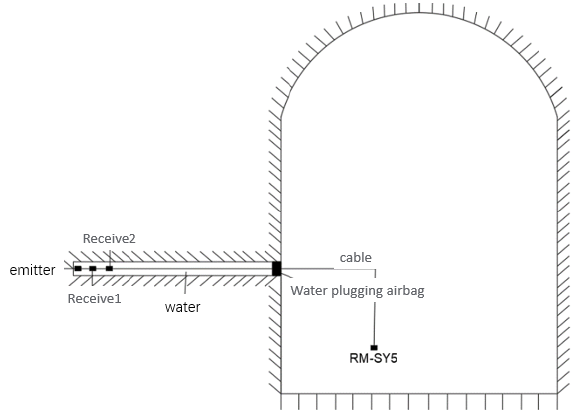
Figure 11. Schematic diagram of the field measurement in the plastic zone of the roadway.